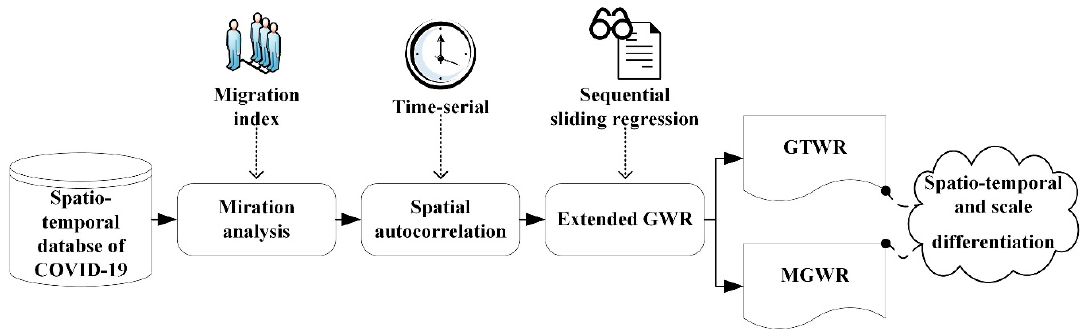
Figure 2. The flow chart of the analysis about COVID-19.